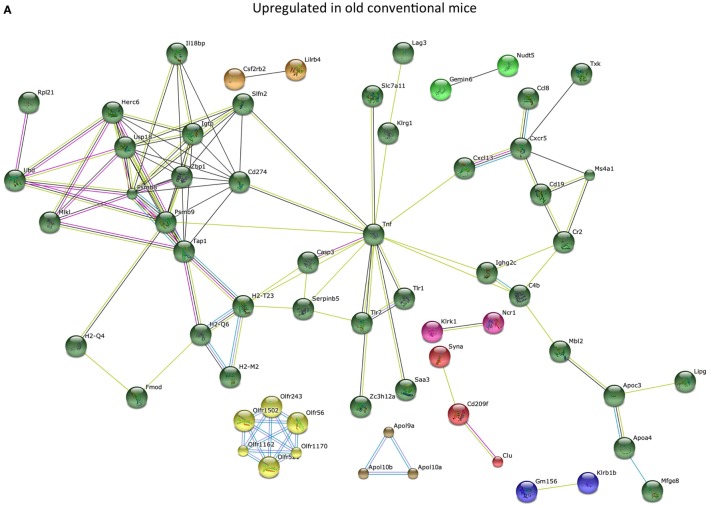
Old microbiota upregulates several immune pathways in the ileum. Whole-genome gene expression in the ileum of mice (n = 5 per group) was assessed with Affymetrix GeneChip Mouse Gene 1.1 ST arrays. The most highly upregulated genes were analyzed with the STRING database. Only genes with at least one interaction are shown. The following interactions are indicated: from curated databases (blue), experimentally determined (pink), textmining (yellow), co-expression (black), and protein homology (purple). (A) Genes that were upregulated (P < 0.05, fold-change >1.3) in the ileum of old conventional mice compared with young conventional mice. (B) Genes that were upregulated (P < 0.05, fold-change >1.2) in the ileum of germ-free (GF) mice that received old microbiota compared with GF mice that received the young microbiota.